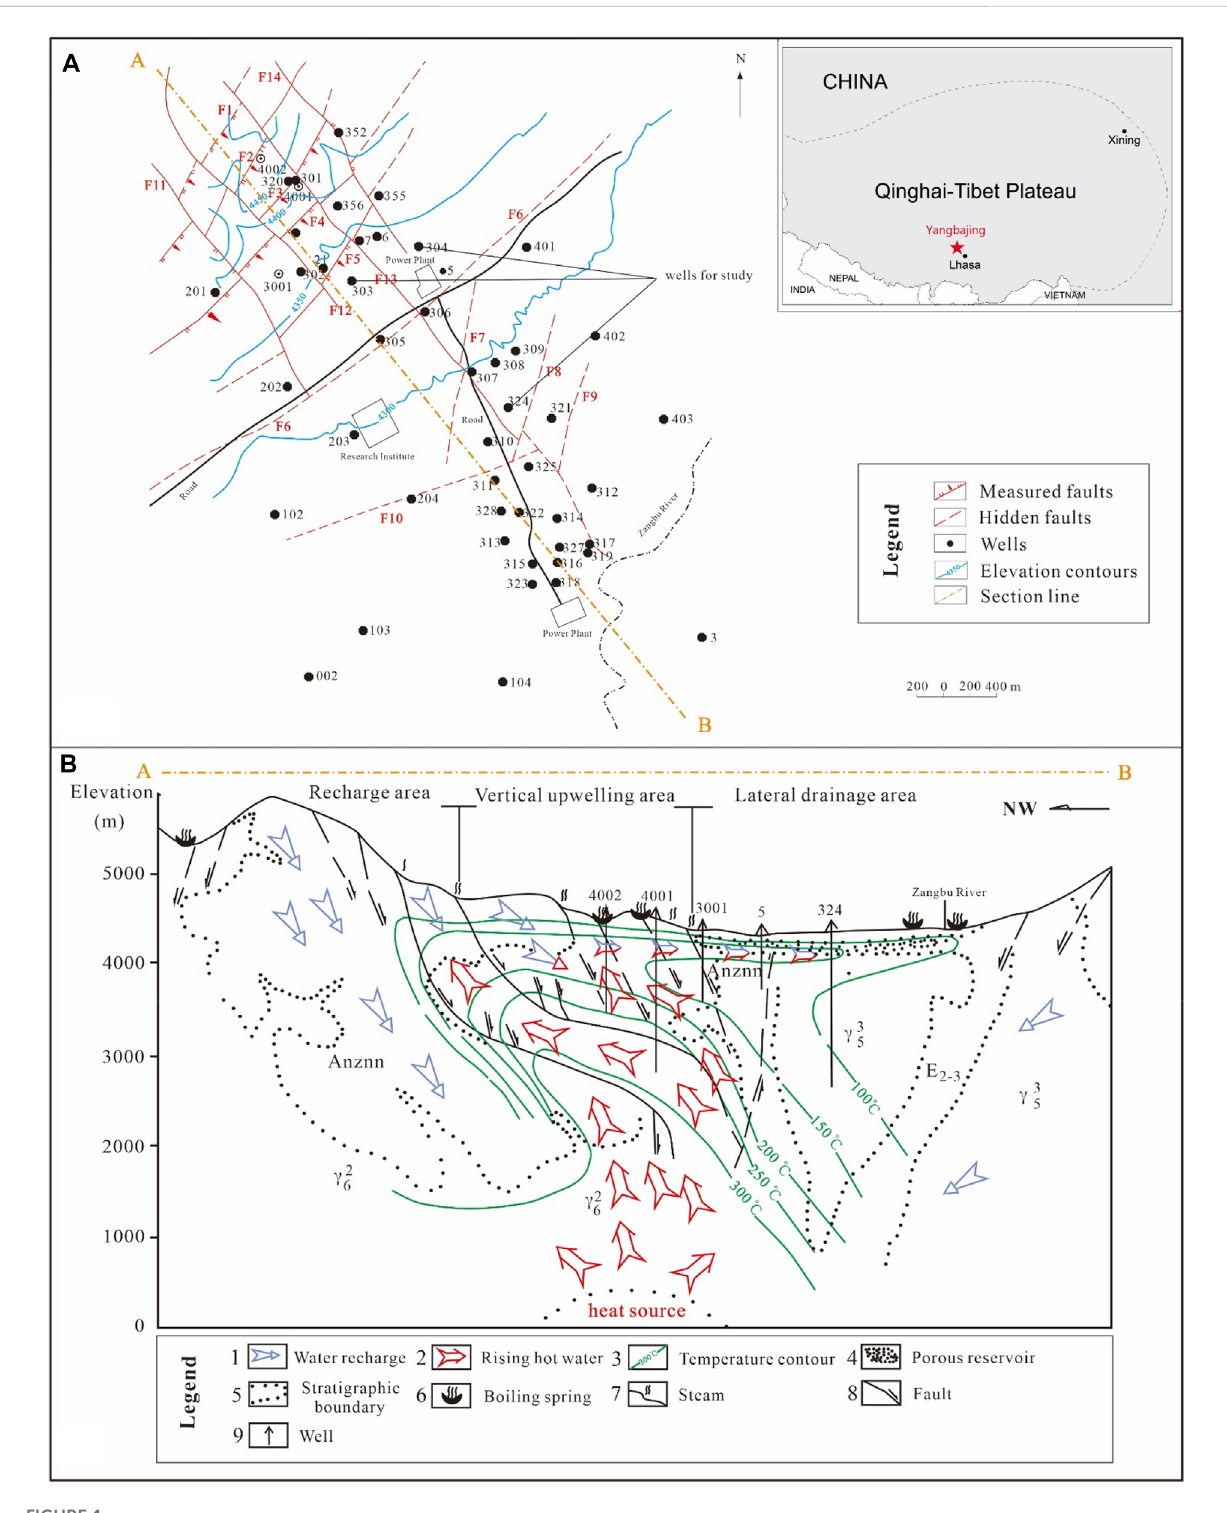
FIGURE 1 The location and geological pro fi le of the study area: (A) plan, (B) cross section (Modi fi ed from Duo, 2003; Xu et al., 2018).